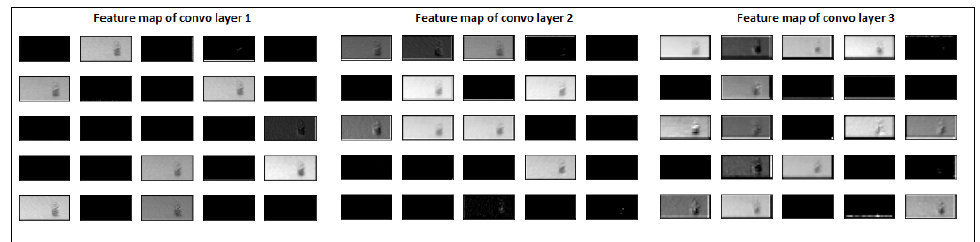
Figure 11. Feature maps of normal layer image 300 after each convolutional layer.